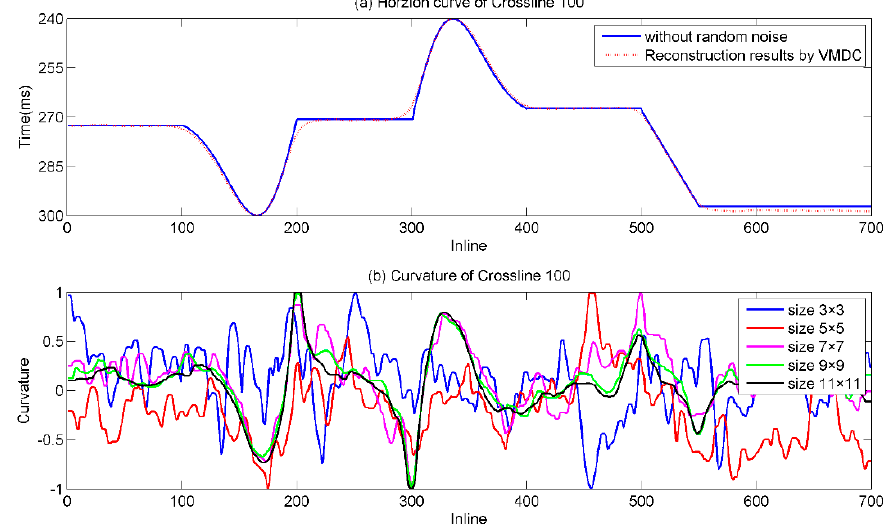
Figure 10. Horizon curve and curvature attributes: ( a ) Reconstruction results of horizon curve by VMDC and ( b ) curvature attributes of different time windows after denoising based on VMDC. Table 7. Correlation coefficient for different time windows after denoising based on VMDC.